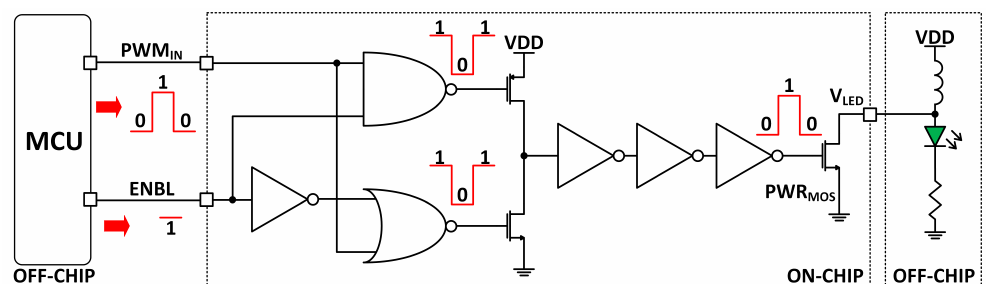
Figure 3. Schematic of the LED driver